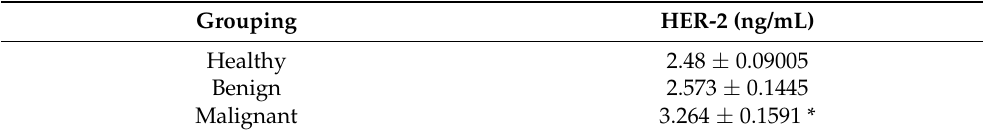
Table 5. Comparison of serum HER-2 levels between the different groups.